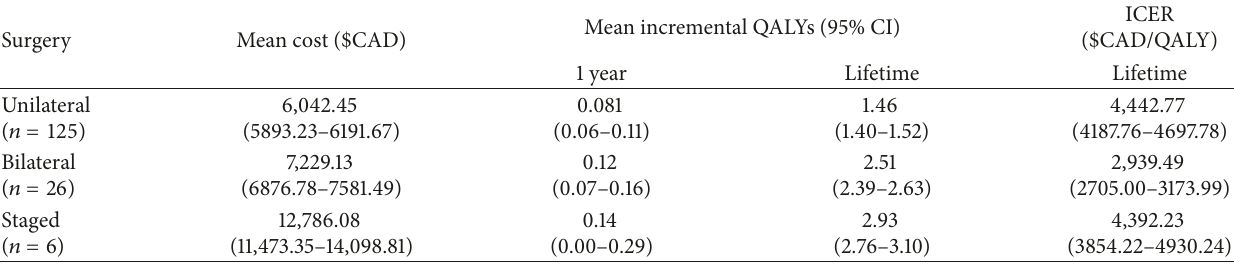
Table 3: Cost, incremental QALYs gained, and ICER for each surgery type.